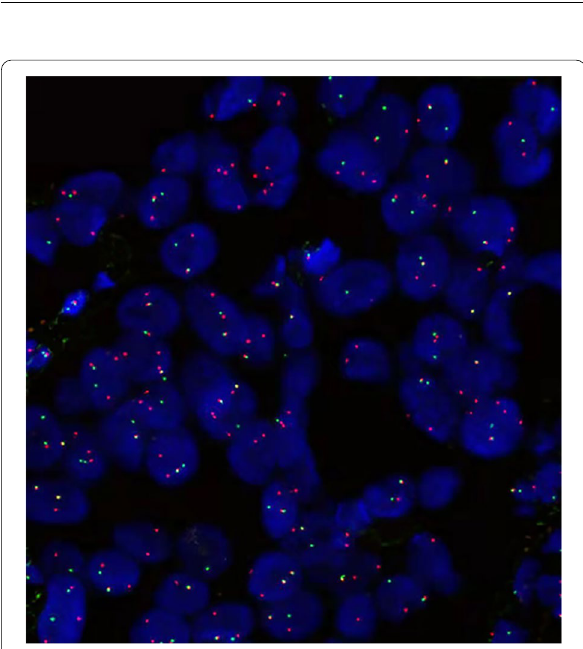
Fig. 2 There was one pair of fusion signals and one pair of break-apart signals in 79% of the tumor